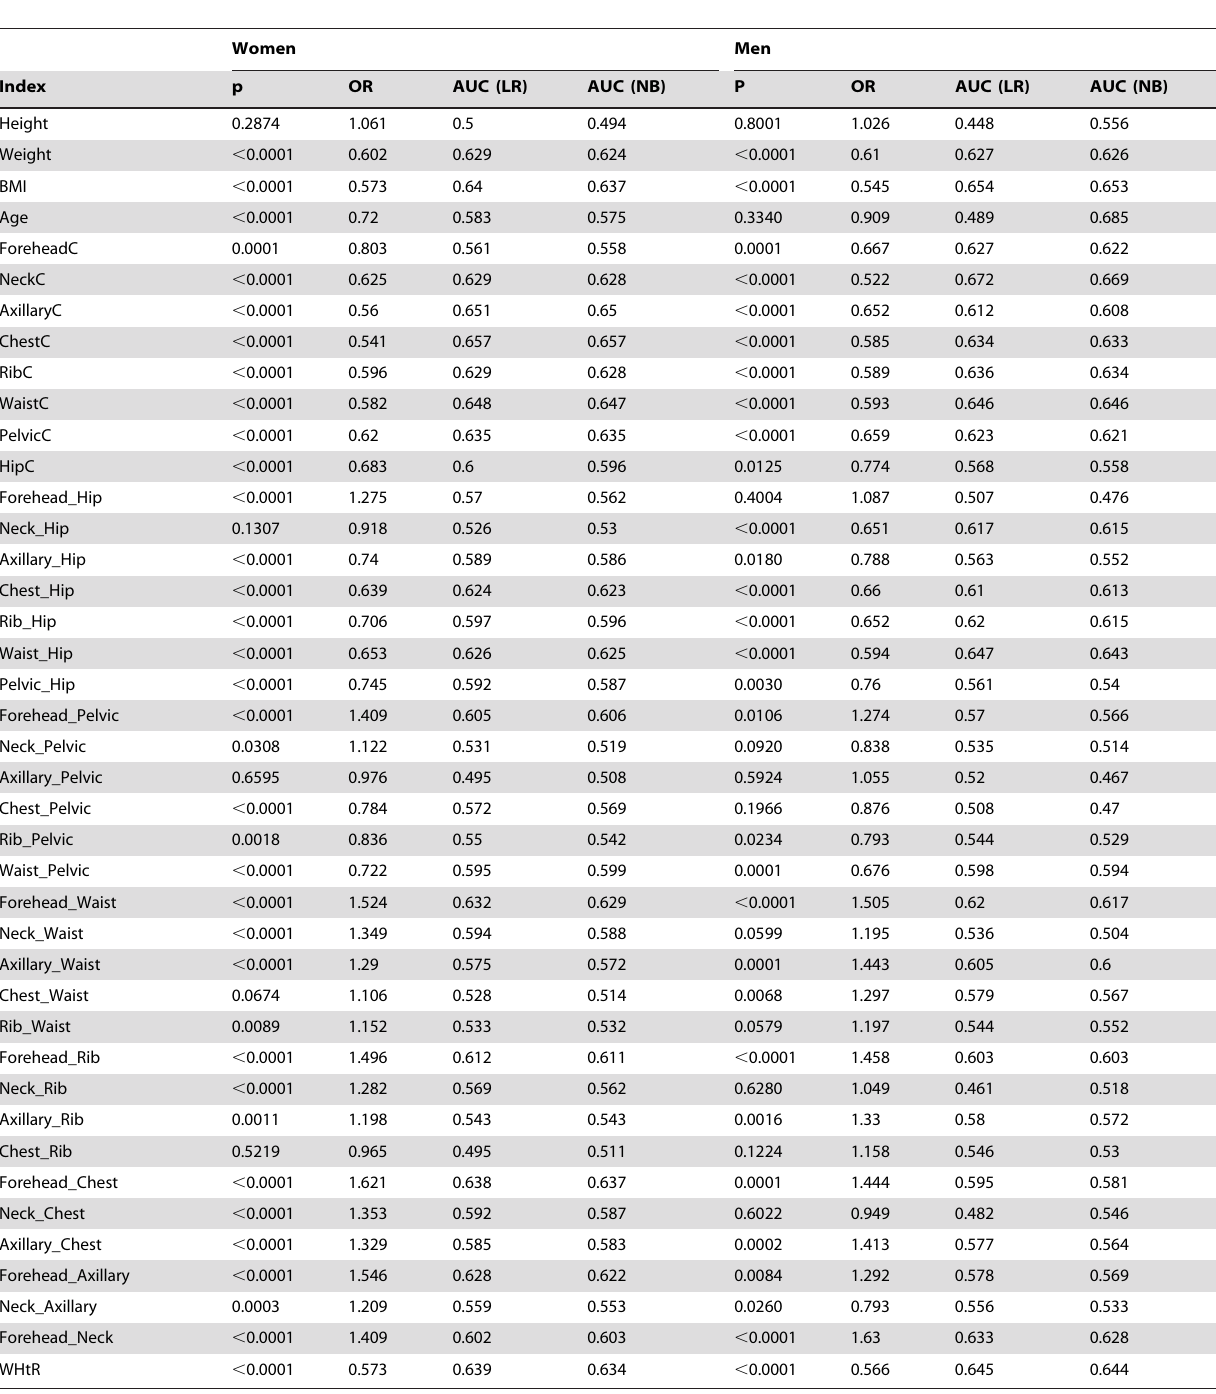
Table 3. Statistical analysis of normotension and hypotension in women and men.